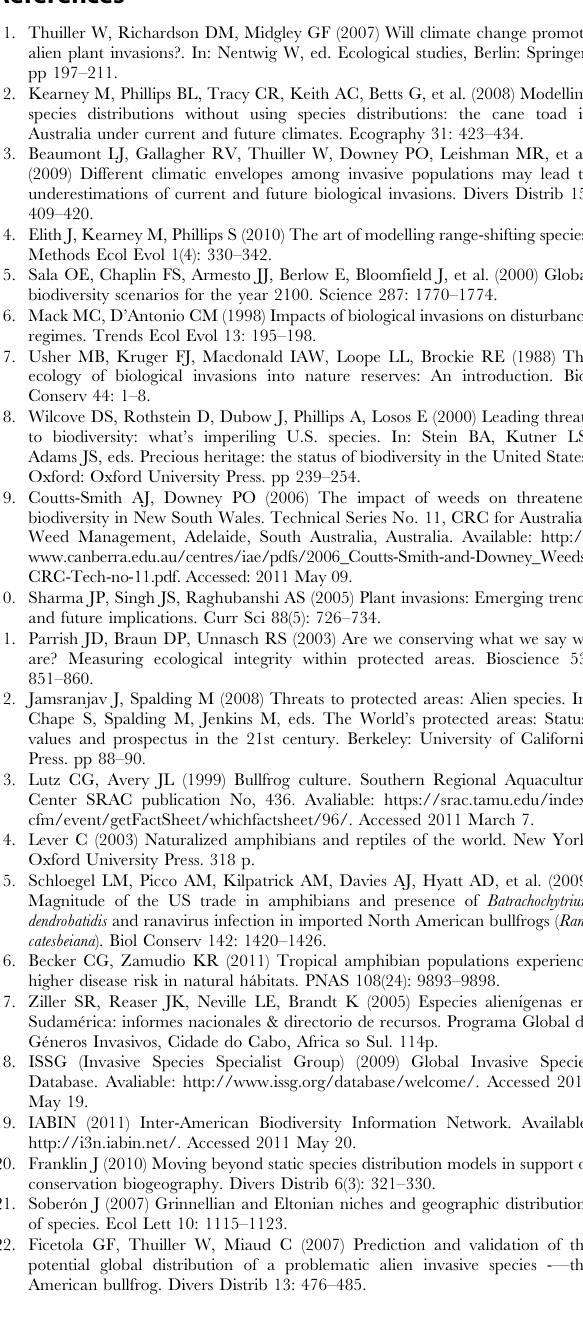
Figure S1 Individual records of Lithobares catesbeianus from its native range used to perfom MaxEnt models and the minimum convex polygon used to calibrate the projections. Table S1 Results of the Pearson correlation between the 20